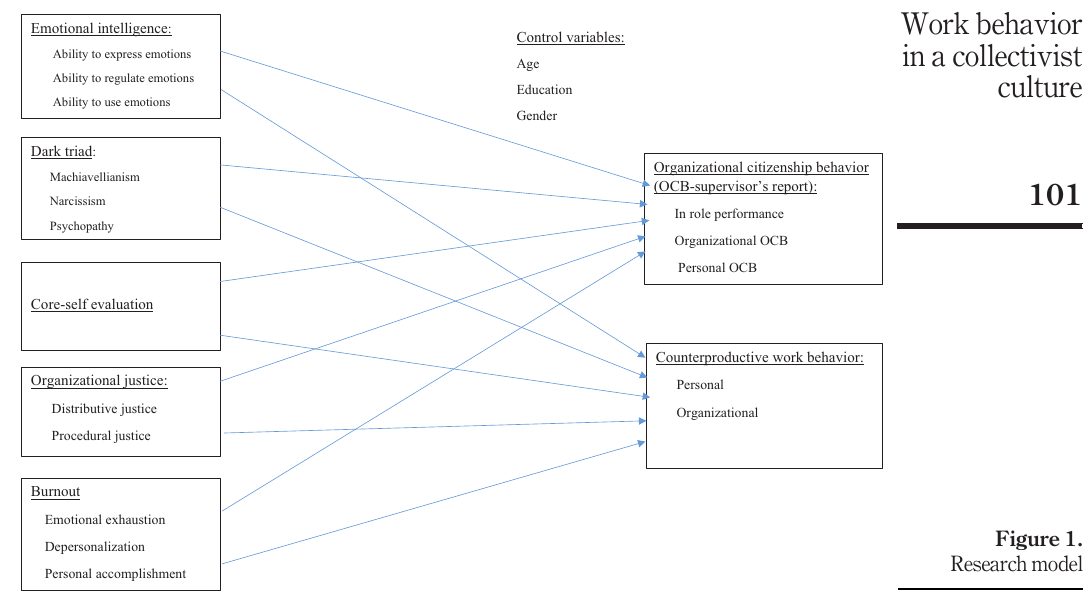
Figure 1. Research